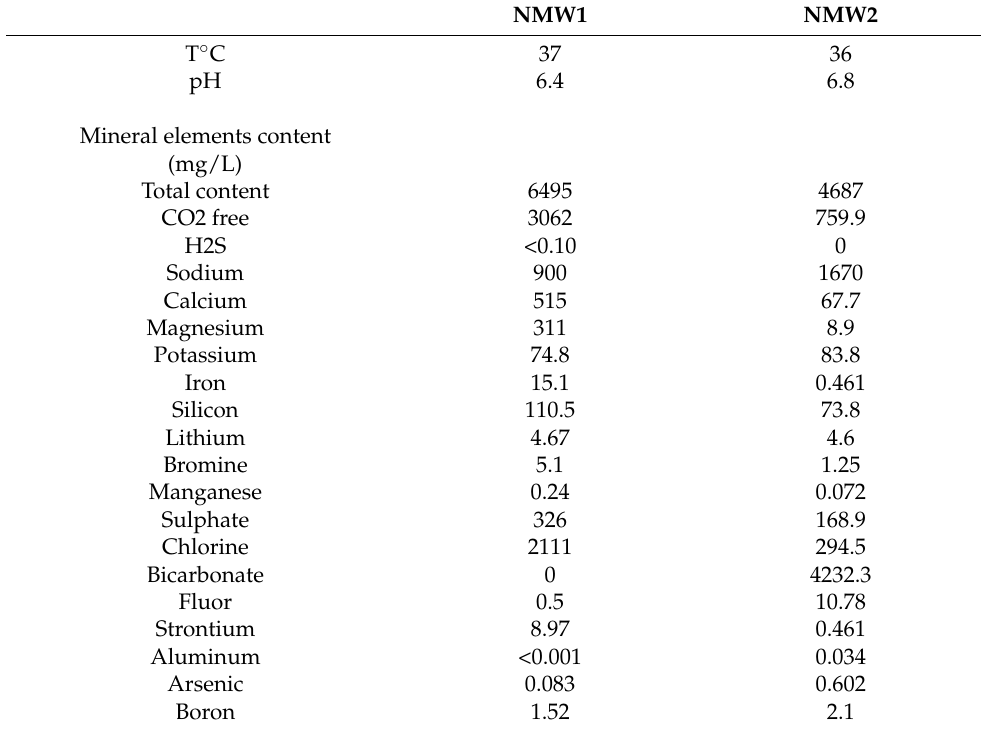
( NMW1 : F3 Spring, Ch â tel-Guyon, Puy de D ô me, France; NMW2 : Antoine and Boussange Springs, Vichy, Allier,